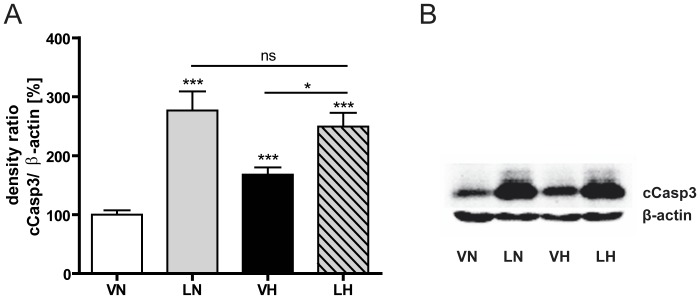
Inflammation and hyperoxia increases cCasp3 expression.Systemic LPS application as well as exposure to 80% oxygen increases caspase-3 activation in the developing rat brain. Results of densitometric western blot quantification (A) and a representative western blot series are shown (B). Animals receiving the two-hit scenario (LH, dashed bar) showed neither a higher nor a faintly cCasp3 expression compared to LPS single-hit treated pups (LN, grey bar). Brain hemisphere extracts were used for western blot analyses with n = 9–11 animals per group. Western blot values represent mean+SEM normalized ratios of the cCasp3 bands to β-actin as an internal standard and VN group was set to 100%. * p<0.05, *** p<0.001 and ns p>0.05; VN: vehicle+normoxia, LN: LPS+normoxia, VH: vehicle+hyperoxia, LH: LPS+hyperoxia.